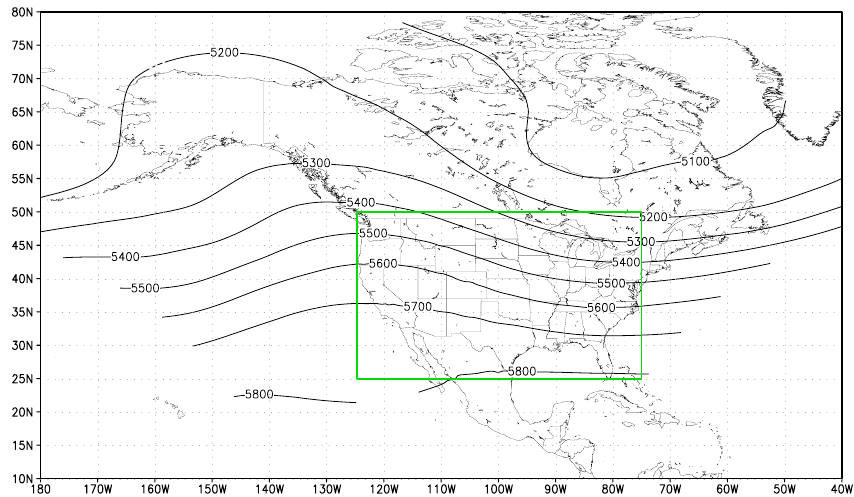
Fig. 1. The limited area domain. Green rectangle indicates the boundary of the forecast verification domain. Thin contours show the time mean of the geopotential height of the pressure level in the ”true“ states.